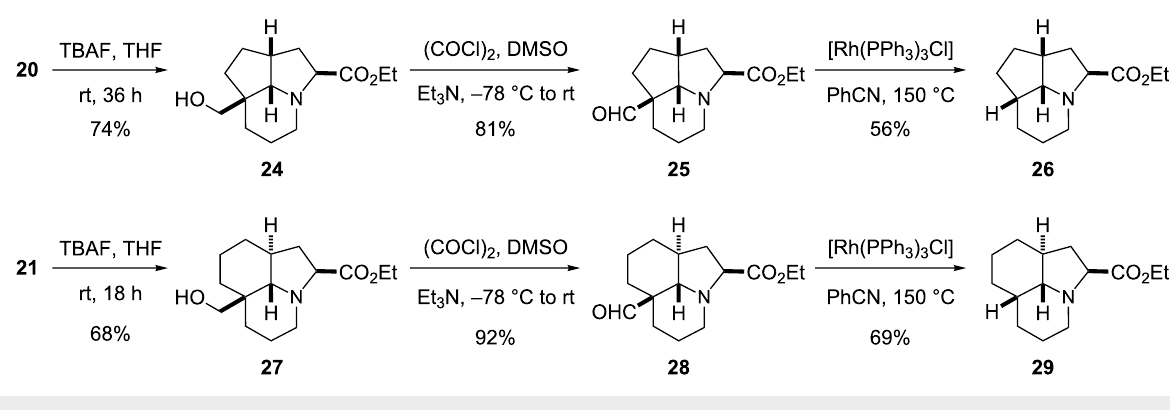
Scheme 8: Decarbonylation reactions to give the products 26 and 29 .